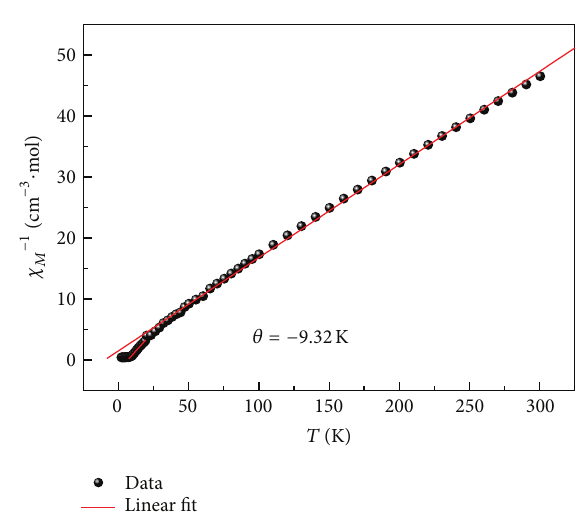
Figure 6: 𝜒 𝑚 −1 versus 𝑇 for the compound.